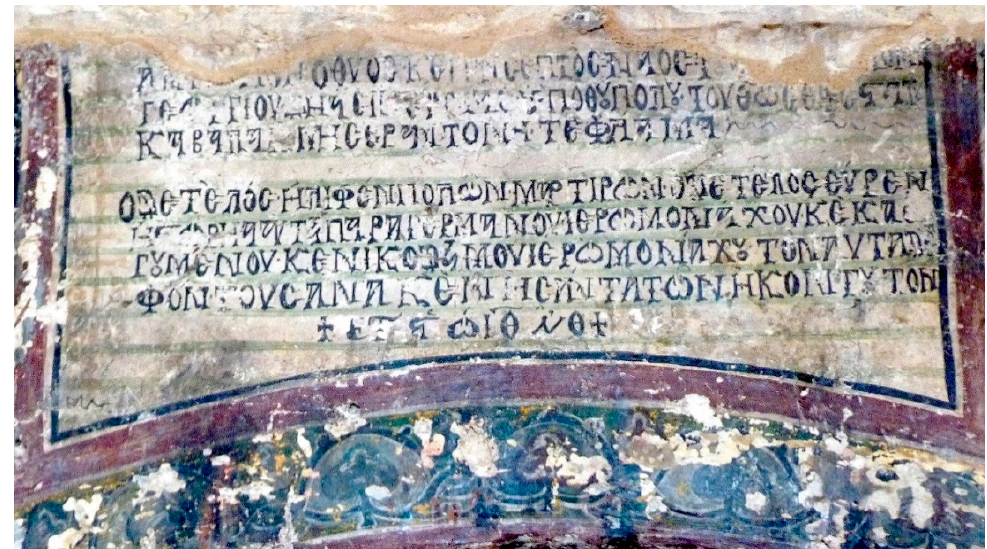
Figure 15. Dedicatory inscription painted above the keystone of the arcosolium (1311), Hagios Georgios in Akraifnio (Karditsa, Boeotia, Greece), south wall of the crossing. © Author with the permission of the Ephorate of Antiquities of Boeotia.